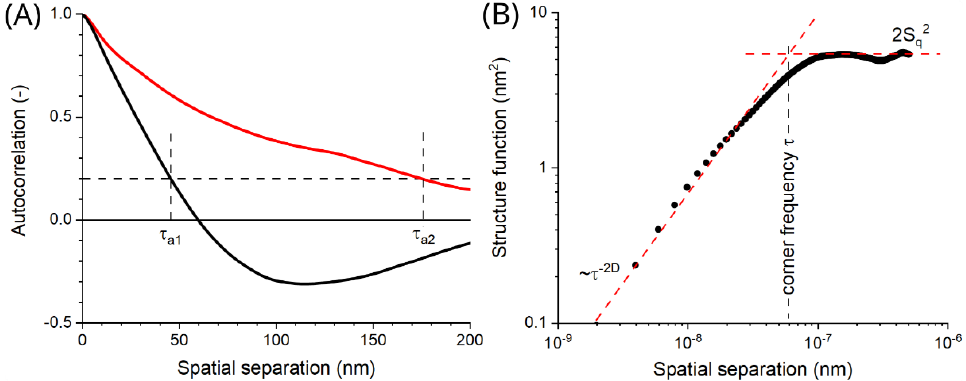
Figure 7. Example curves derived from the AFM images of the composite films that are helpful in obtaining spatial characteristics of their complex surface geometry: ( A ) Profile plots of the autocorrelation function along with directions of its extreme decay lengths: τ a 1 and τ a 2 , respectively; ( B ) double-log structure function with the threshold of the allometric scaling behavior – corner frequency τ — marked with the dashed line.